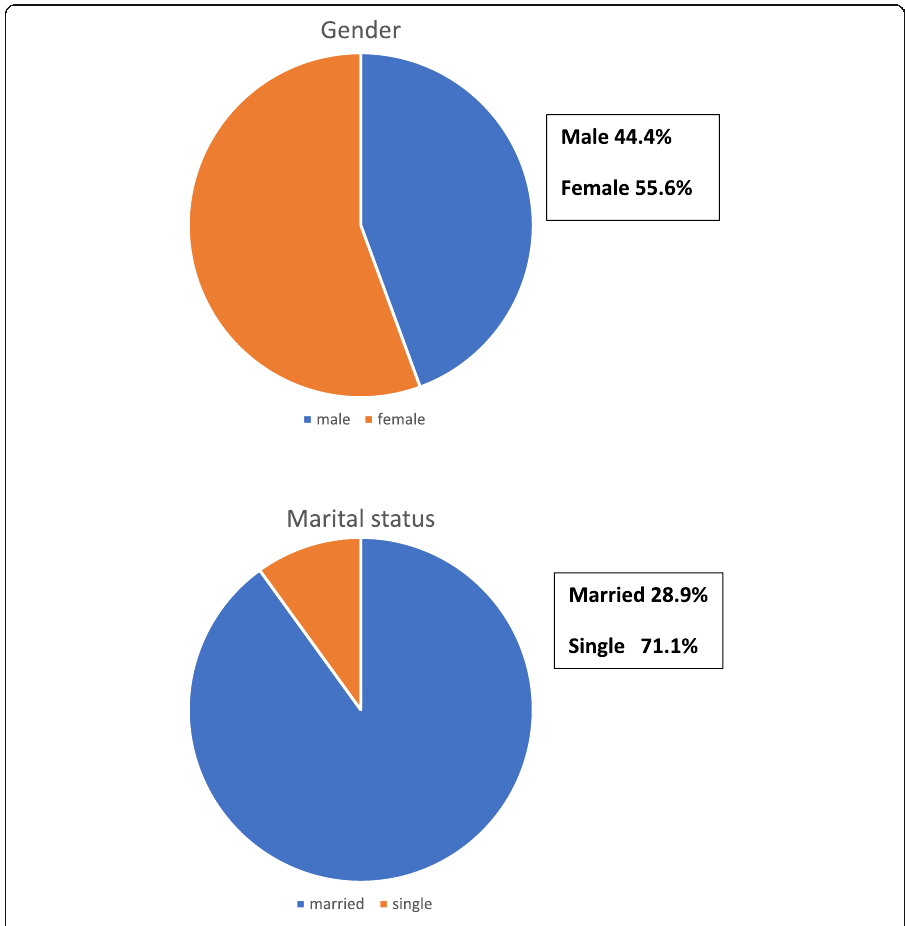
Fig. 1 Percentage of male, female, married and single